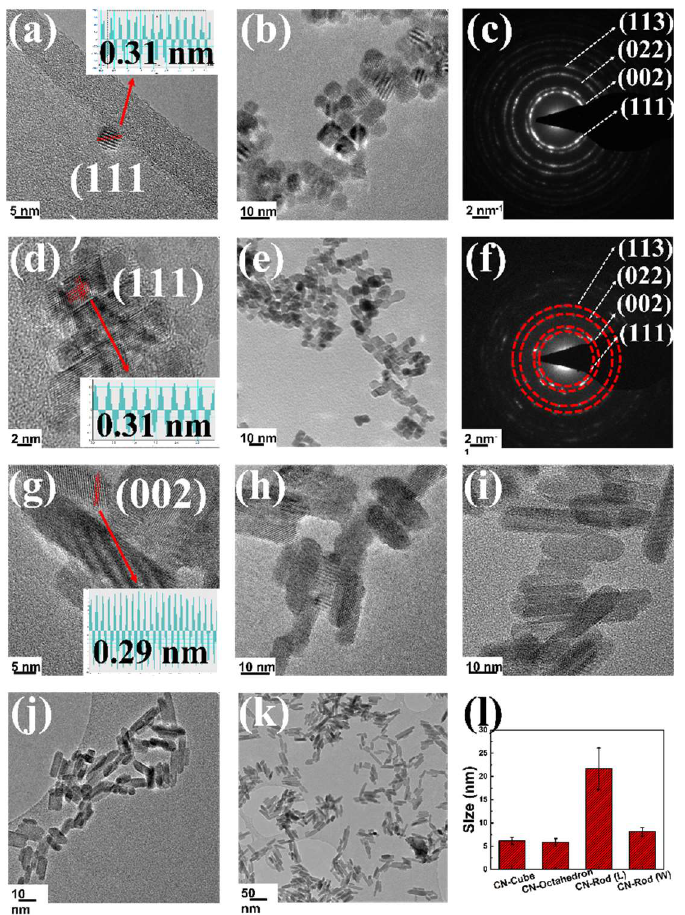
Figure 3. ( a – k ) Shows TEM analysis of CNPs of various morphologies. ( a , b ) show CNPs of cubic morphologies, with an average size of 6.13 ± 0.74 nm (estimated along the diagonals), and ( c ) shows the corresponding SAED pattern. ( d , e ) show octahedron-shaped CNPs with an average size of 5.8 ± 0.85 nm, and ( f ) shows a corresponding SAED pattern. ( g – k ) show rod-shaped CNPs with an average length of 21.6 ± 4.5 nm and a width of 8.1 ± 0.96 nm. ( l ) shows a bar graph of the size estimation of different morphologies of CNPs, Cubes, octahedrons, and rods. It can be observed in all three morphologies particle sizes are relatively uniform. In the case of rods, an average aspect ratio of 21:8 (length:width) has been demonstrated. The interplanar distance was estimated for one the rod sample ( g ), using Digital micrograph software, to be ~2.9 nm (likely related to the (002) plane). All other size estimation was performed using ImageJ